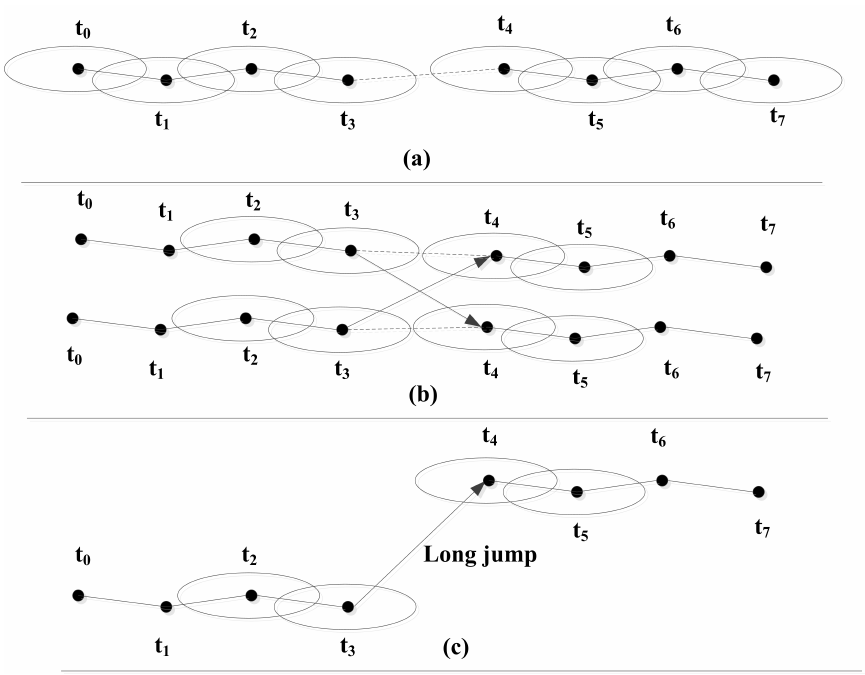
3 is incorrectly 3